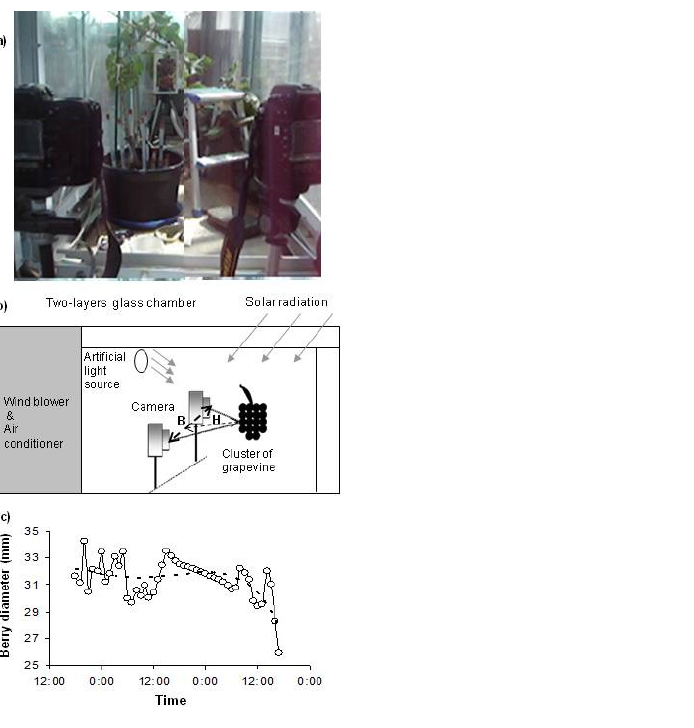
Figure 1. Schematic illustration of experimental setup ( a , b ) and diurnal variations in a time series of berry diameter (berry No. 2) in berry development Stage III ( c ). The solid line represents the measured berry diameter, and the dashed line represents the trend. When the berries were in the maturation stage, a pot containing the grapevine was placed in a wind tunnel with a two-layer glass chamber in a glass dome building of the Arid Land Research Center, Tottori University, Tottori (35°15 ′ N, 133°47 ′ E), Japan. Natural solar radiation can pass through the glass dome. In the glass chamber, an artificial light source was set 0.5 m higher than the top of the grapevine to supply sufficient radiation energy; the diurnal artificial luminous intensity, relative humidity and air flow were set at 3000 µ mol m − 2 s − 1 , 50% and 0.3 m s − 1 , respectively. The air temperature was set to 12/12 h (day/night) cycles of 35/20 ◦ C. After placement in the wind tunnel, the pots were irrigated to saturation. No irrigation was applied until the end of this experiment and the grapevine experienced deceasing ψ